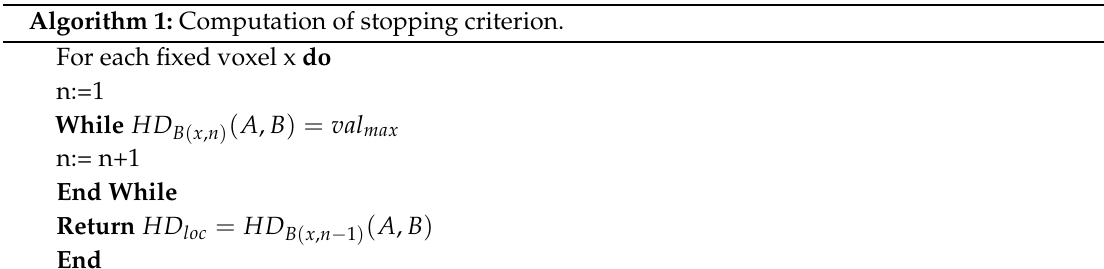
Algorithm 1: Computation of stopping